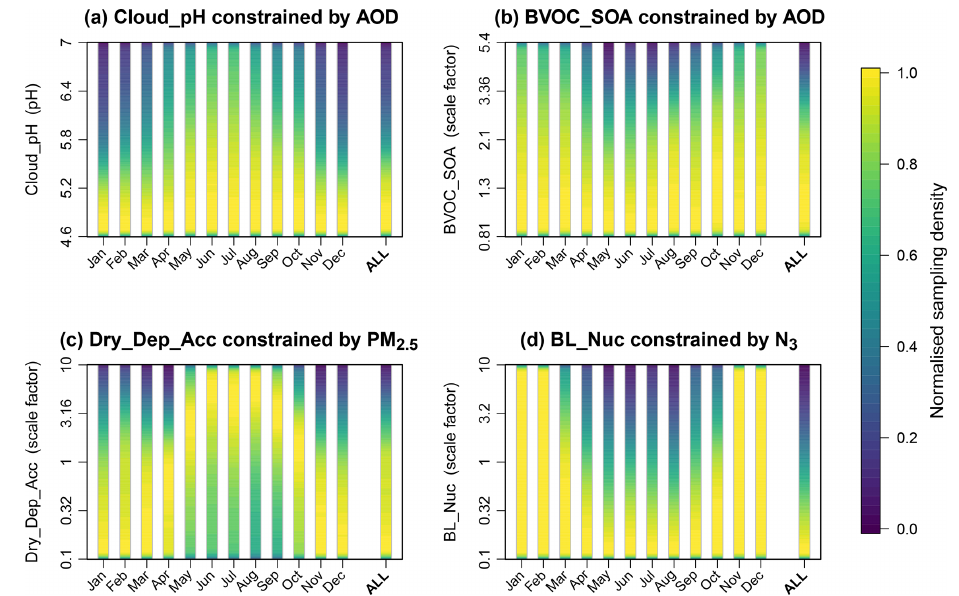
Figure 7. Seasonal variation in the constraint of parameter marginal probability distributions. The examples are (a) constraint of the pH of cloud droplets (Cloud_pH) parameter using global AOD measurements, (b) constraint of SOA production from BVOCs (BVOC_SOA) using AOD measurements, (c) constraint of the dry deposition rate of accumulation-mode particles (Dry_Dep_Acc) using global PM 2 . 5 measurements and (d) constraint of boundary layer nucleation rates (BL_Nuc) using N 3 measurements mainly over